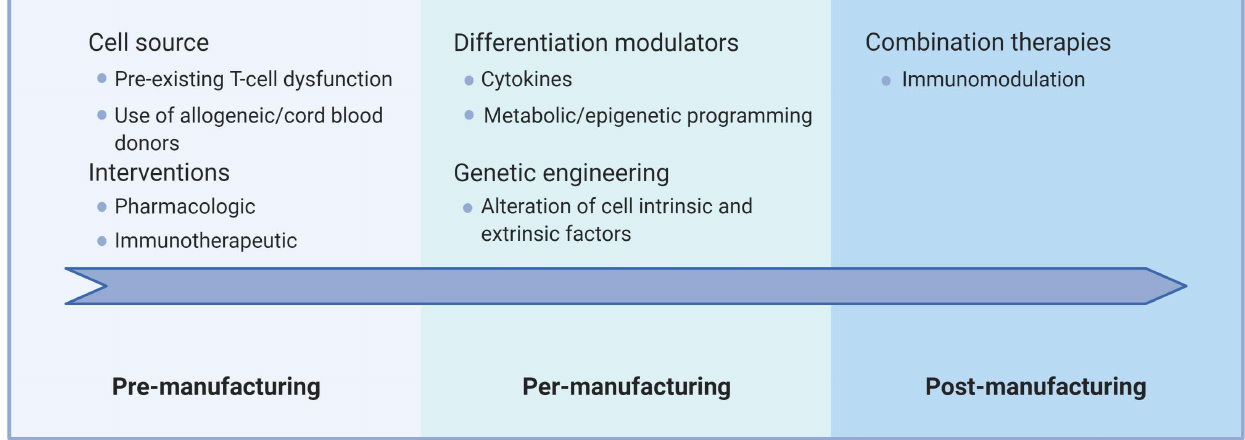
Figure 4. Synthetic representation of concerns and interventions aimed at limiting cell dysfunction before, during, and after manufacturing process. This figure was created with